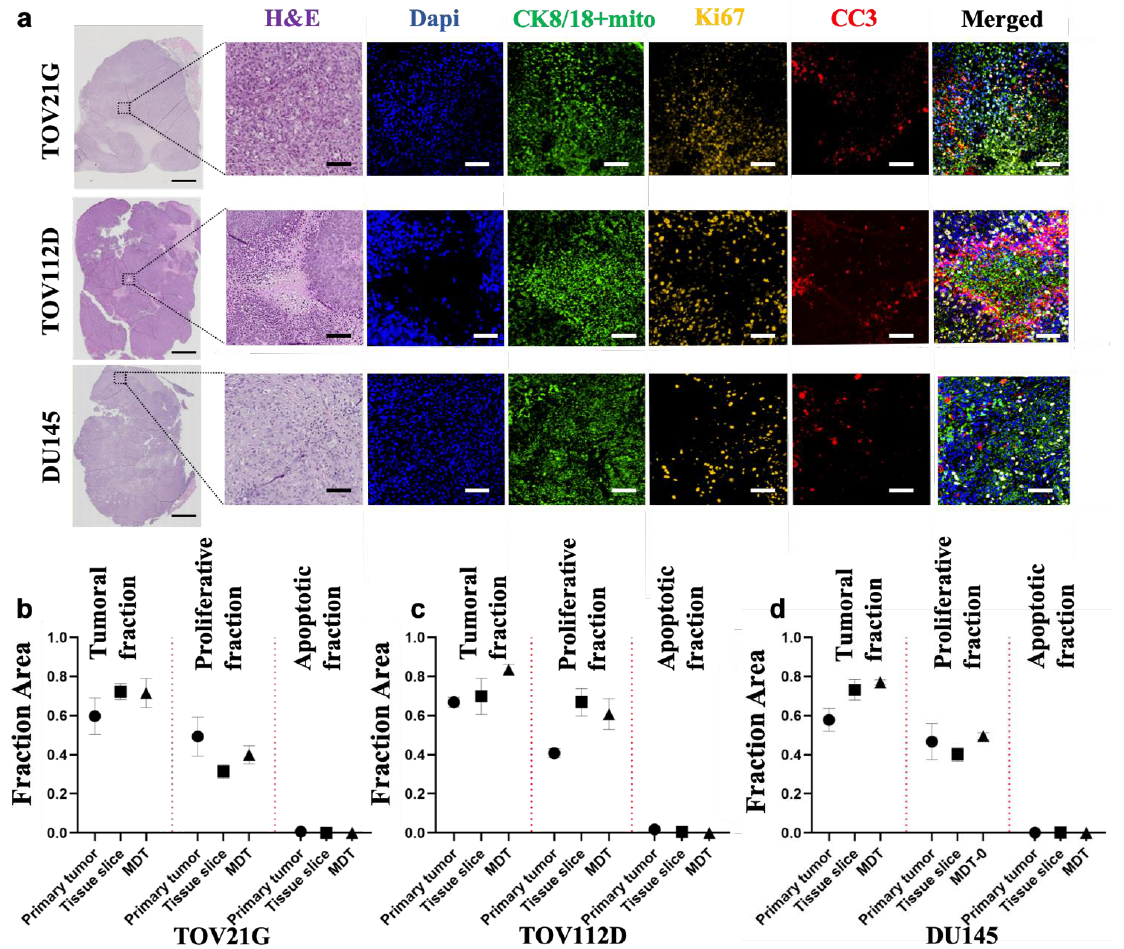
Figure 2. Characteristics of primary xenografts and tumor models of ovarian and prostate cancers. ( a ) Cross sections and staining of the entire primary xenograft tissues of ovarian cancer cell line (TOV21G and TOV112D) and prostate cancer cell line (DU145). Magnified tissue areas stained with H&E, tumor cell marker (CK8/18 + mito), proliferation marker (Ki67), and apoptosis marker (CC3). ( b – d ) IF scoring of primary xenograft and tumor models of TOV112D ( b ), TOV21G ( c ) and DU145 ( d ). All experiments were performed on the same xenograft as the starting material. Scale bars = 1 mm in whole tissue images and 100 μm in magnified images. Error bars = ±SEM.